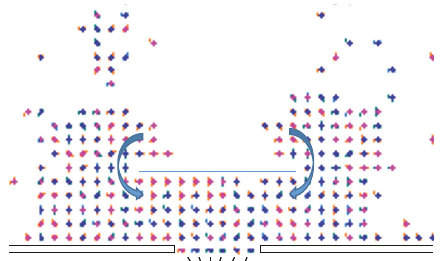
Figure 2: Evacuation with shunt wall.